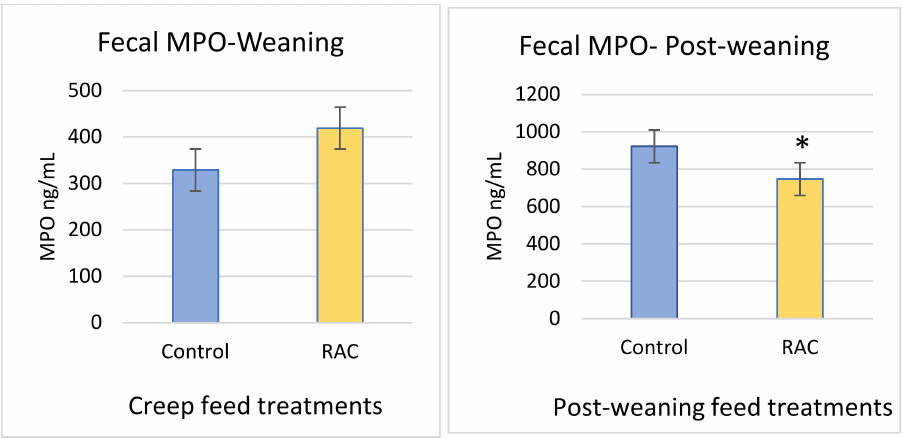
Figure 5. Fecal myeloperoxidase (MPO) level at weaning, and post weaning. * p <